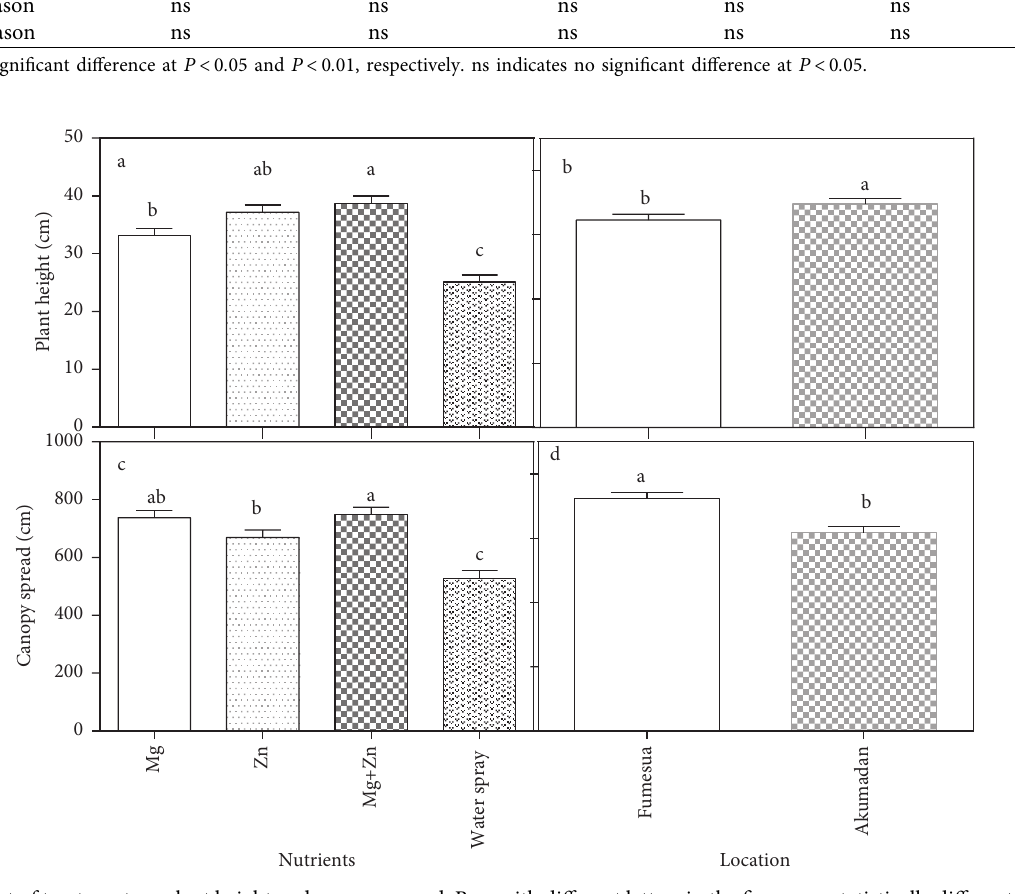
Figure 1: Effect of treatment on plant height and canopy spread. Bars with different letters in the figure are statistically different at P < 0 . 05. Error bars represent the standard error of means. Means comparison was done using Tukey HSD (honestly significant difference) ( P < 0 .